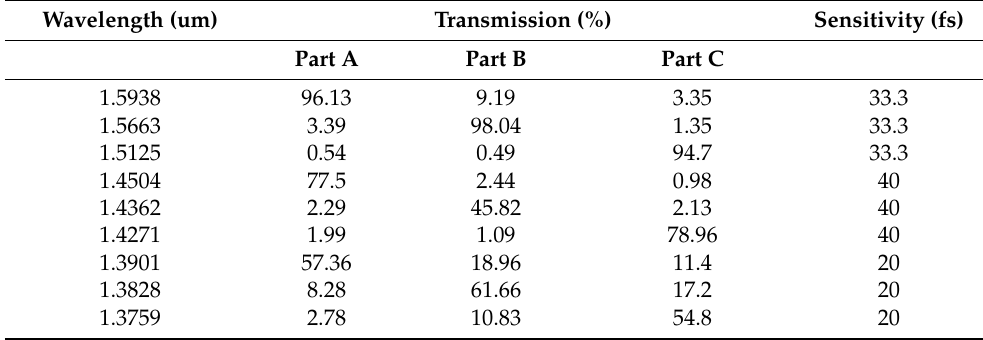
Figure 10. ( a – c ) Distribution of Ey at different wavelengths. Table 3. Download efficiency, crosstalk, and sensitivity of each channel of the filter for different wavelengths.